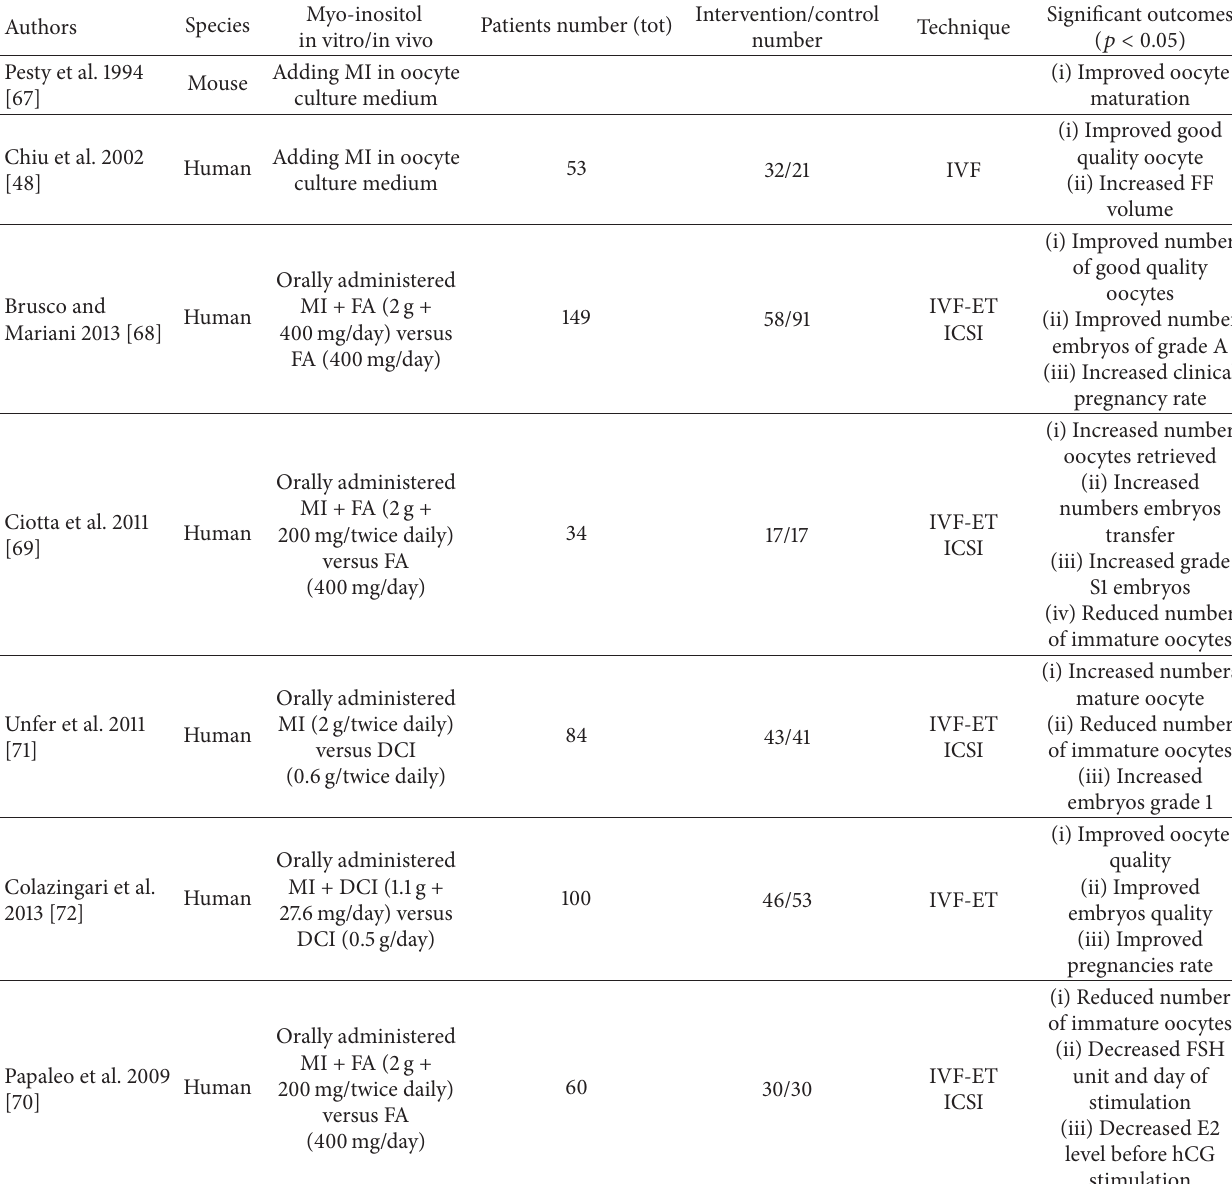
Table 2: Effects of myo-inositol supplementation therapy (adding in oocytes culture or orally administered to patients) during ART.